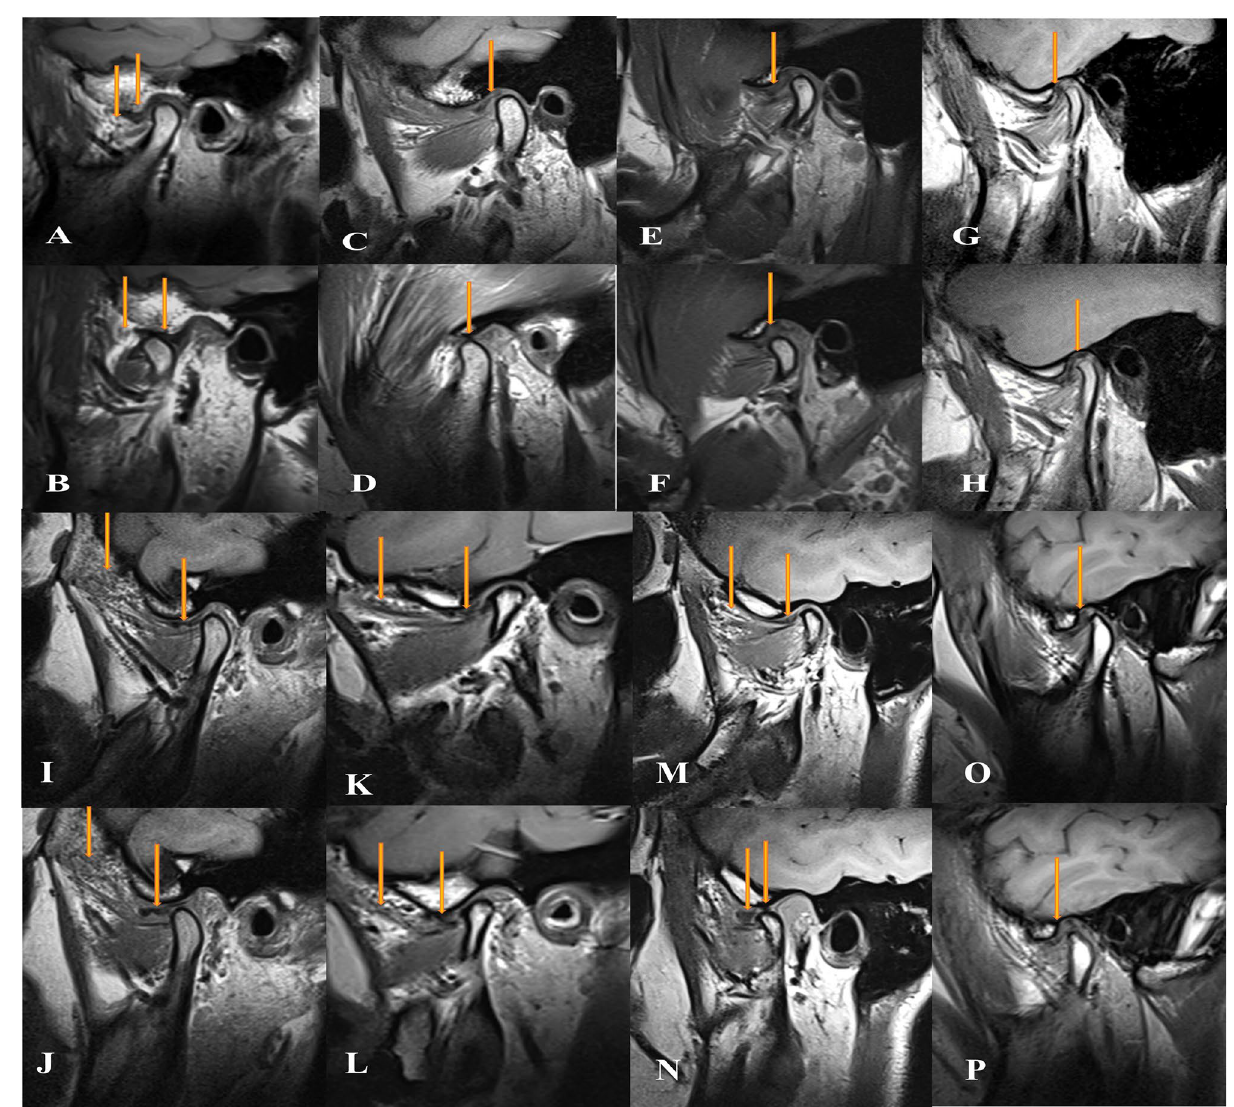
Figure 3. Oblique sagittal T1-weighted images represent stage 2A in close ( A ) and open ( B ) mouth position, DDR associated with fatty degeneration of the Superior head of lateral pterygoid muscle (SLPM) (the arrow). Oblique sagittal T1-weighted images represent stage 2B in close ( C ) and open ( D ) mouth position, with Disk displacement with reduction (DDR) with disk perforation (the arrow). Oblique sagittal T1-weighted images represent stage 2B in close ( E ) and open ( F ) mouth position with DDR associated with stuck disk phenomena (the arrow). Pre-treatment ( G ) oblique sagittal T1-weighted images represent stage 2B, DDR associated with fatty degeneration of the SLPM, disk degeneration, and osteoarthritis of the condyle & Post-treatment ( H ) oblique sagittal T1-weighted images showed disk recapture and condylar remodeling after using the non- surgical treatment protocol. Oblique sagittal T1-weighted images represent stage 3A in close ( I ) and open ( J ) mouth position, Disk displacement without reduction (DDNR) associated with fatty degeneration of the SLPM (the arrow). Oblique sagittal T1-weighted images represent stage 3B in close ( K ) and open ( L ) mouth position, with DDR with disk degeneration (the arrow) and sever osteoarthritic changes of the condyle. Oblique sagittal T1-weighted images represent stage 3C in close ( M ) and open ( N ) mouth position with DDNR associated with fatty degeneration of the SLPM (the arrow), disk degeneration (the arrow), arthritis of the condyle and perforation of the posterior attachment (the arrow in open mouth position). Pre-treatment ( O ) oblique sagittal T1-weighted images represent stage 3C, DDNR associated with Stuck Disk & Post-treatment ( P ) oblique sagittal T1-weighted images showed disk recapture after using the non-surgical treatment